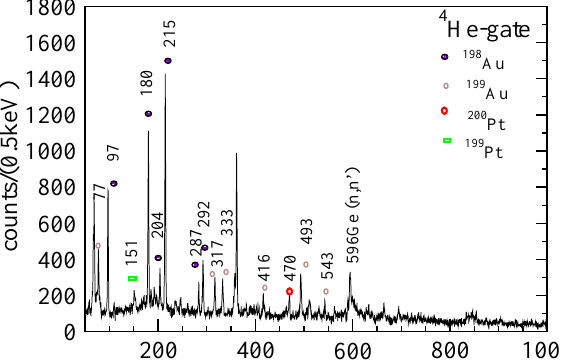
Fig. 6. (color on line) Prompt γ -ray spectra for E lab = 45 MeV obtained in coincidence with outgoing fragment 4 He. The γ -ray transitions originating from the residues from capture of t are marked. The γ -ray arising from 1n and 2n-transfer ( 199 , 200 Pt) are also